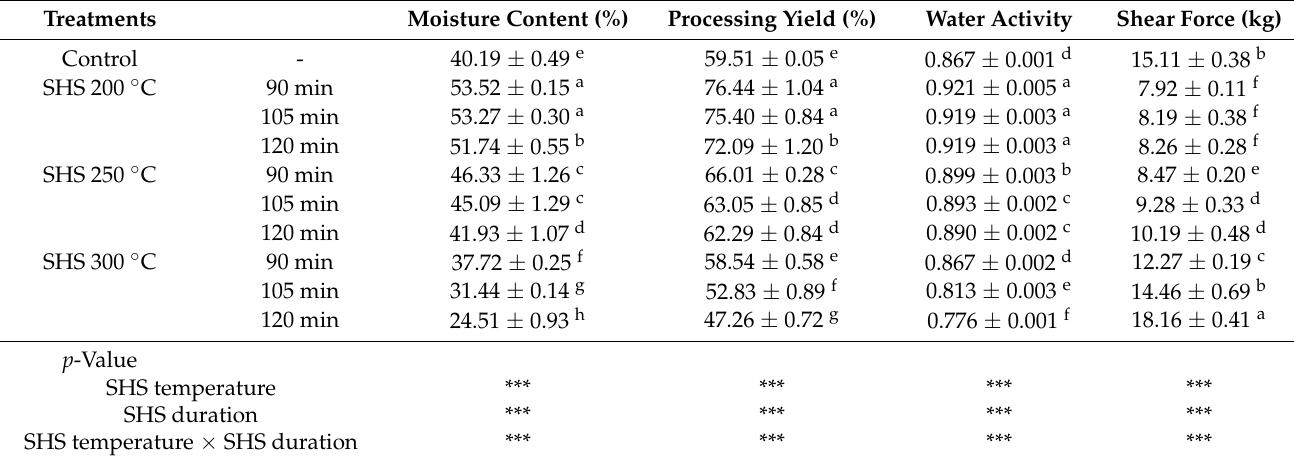
Table 1. Moisture content, processing yield, water activity, and sheer force of semi-dried restructured jerky processed with super-heated steam (SHS). Treatments Moisture Content (%) Processing Yield (%) Water Activity Shear Force